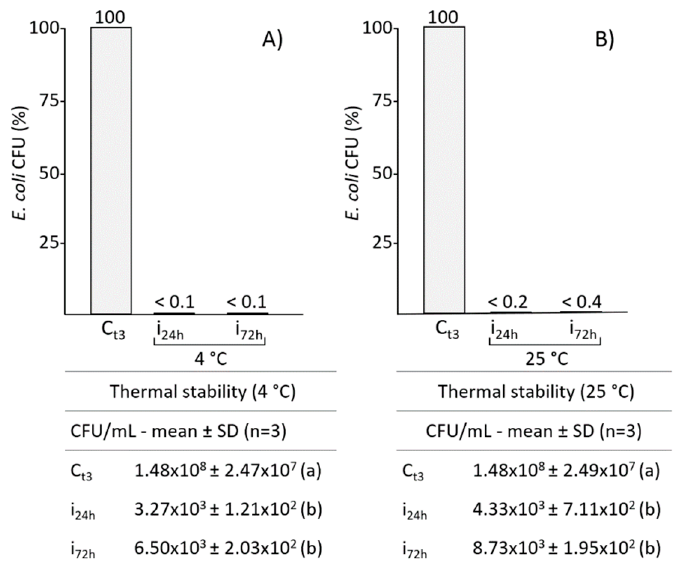
Figure 5. The activity of B. mori fractioned plasma, from infected larvae, was assayed for antibacterial properties after conservation at 4 ( A ) and 25 °C ( B ), for 24 and 72 h. Tables below present the E. coli growth expressed as CFU/mL. Different letters within brackets (a,b) indicate significant differences ( p < 0.05, Tukey test). C: control; i: plasma from infected larvae.